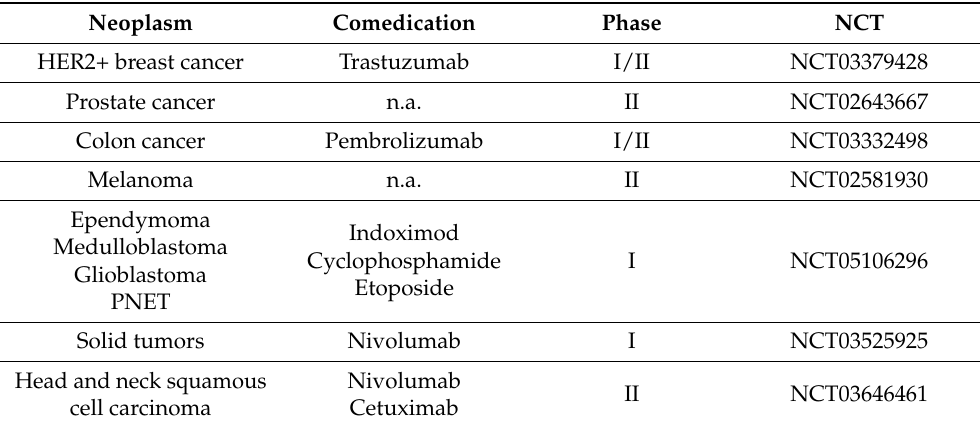
Table 3. Ibrutinib in solid tumors: currently undergoing clinical